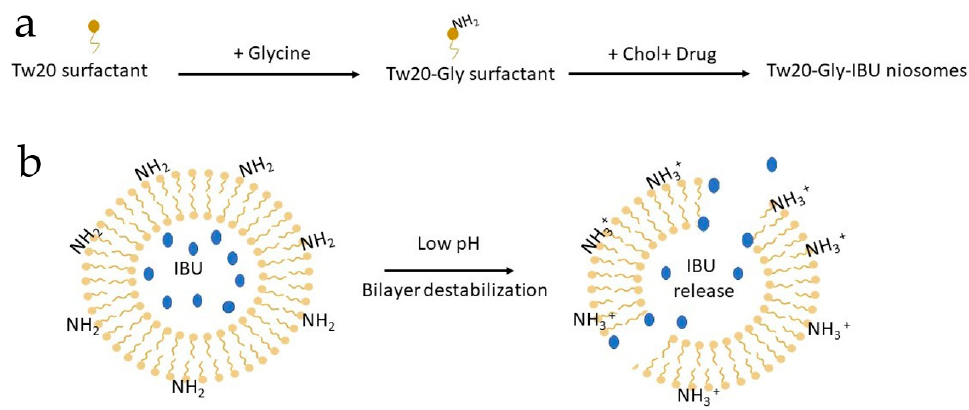
Figure 1. Cartoon describing: ( a ) niosomal preparation by a derivatized surfactant; and ( b ) bilayer destabilization at an acidic pH and consequent drug release. IBU is for Ibuprofen.